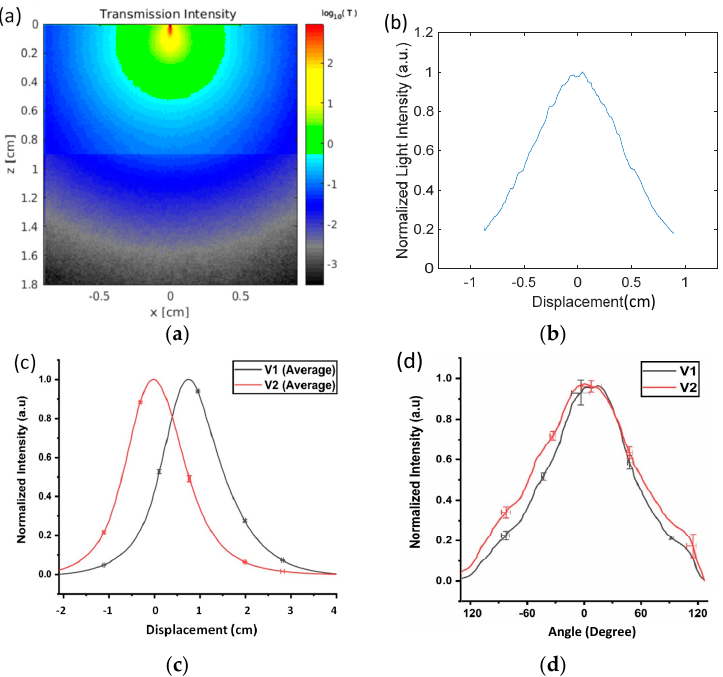
Figure 4. Simulation and ex vivo experimental results from adipose- and muscle-rich porcine tissues: ( a ) simulated photon distribution inside the tissue, ( b ) simulated light transmission vs. displacement, and normalized average voltages (V1 and V2) ( c ) from 16 repeated measurements in response to the translation of the optical fiber against the porcine tissue and ( d ) from 10 repeated measurements in response to the fiber rotation against the